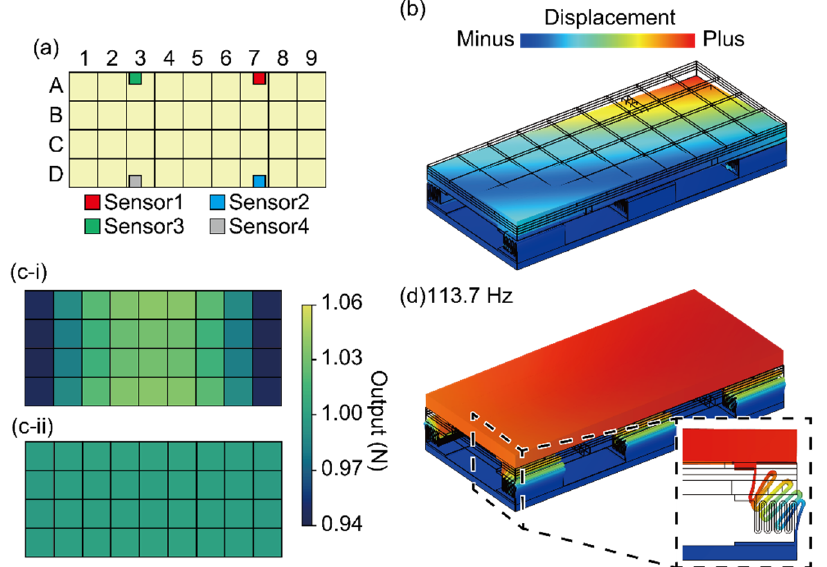
Figure 3. ( a ) Schematic image of the divided area. ( b ) Simulation result of the deformation when F z is added to A9. Position error in the ( c-i ) z -direction and ( c-ii ) y -direction. ( d ) Simulation result of the first resonant frequency.